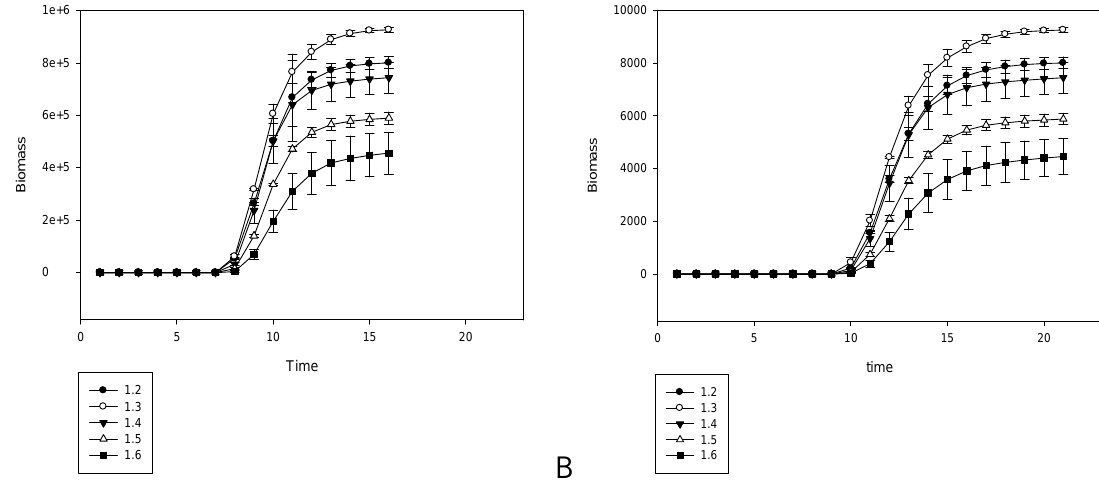
Fig. 6. Mean dynamics of biomass at the middle of each subsample (5th segment) with “unlimited” (A) and limited (B) resource, for soils at bulk-densities of 1.2, 1.3, 1.4, 1.5, and 1.6g/cm 3 . Note that the scales for the amount of biomass differ for both resource levels.